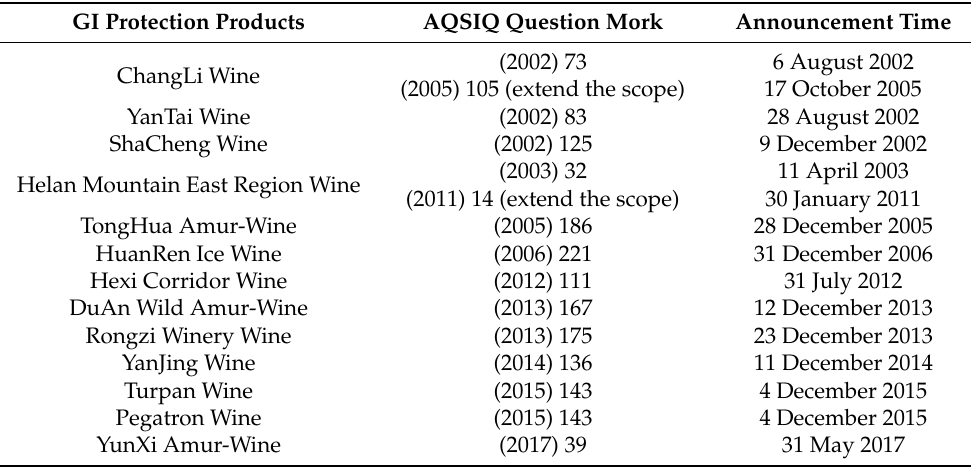
Table 10. Products protected by geographical indications of wine in